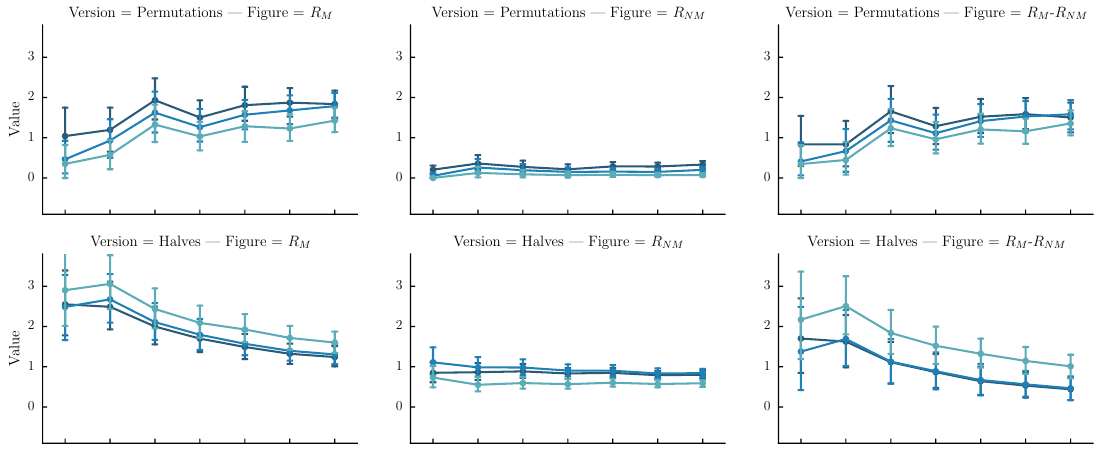
Version = Halves And Shifts — Figure = R M - R NM